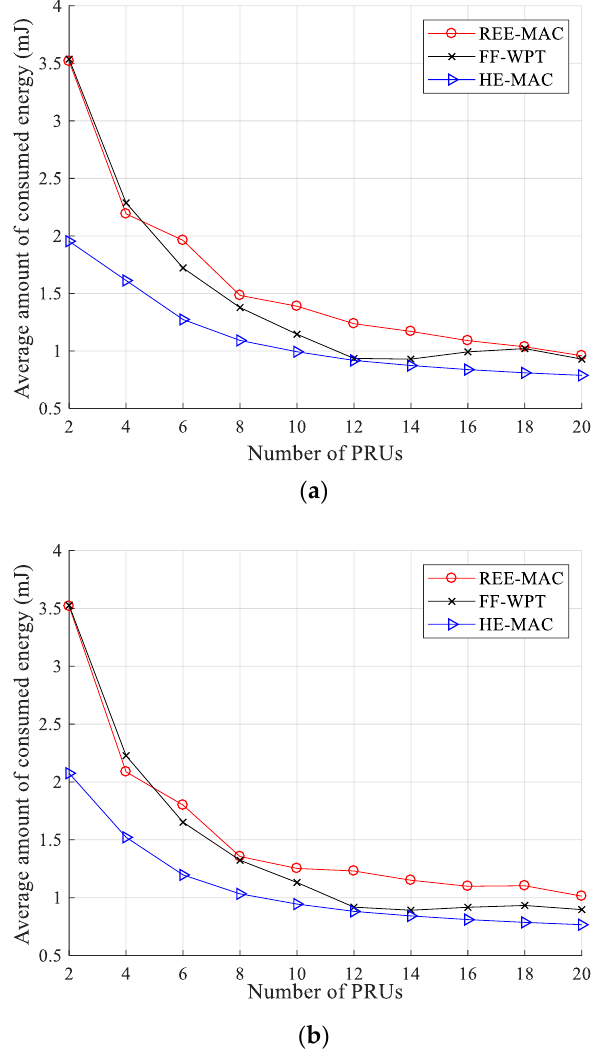
Figure 6. Average consumed energy: ( a ) packet size of 100 bytes; ( b ) packet size of 200 bytes.